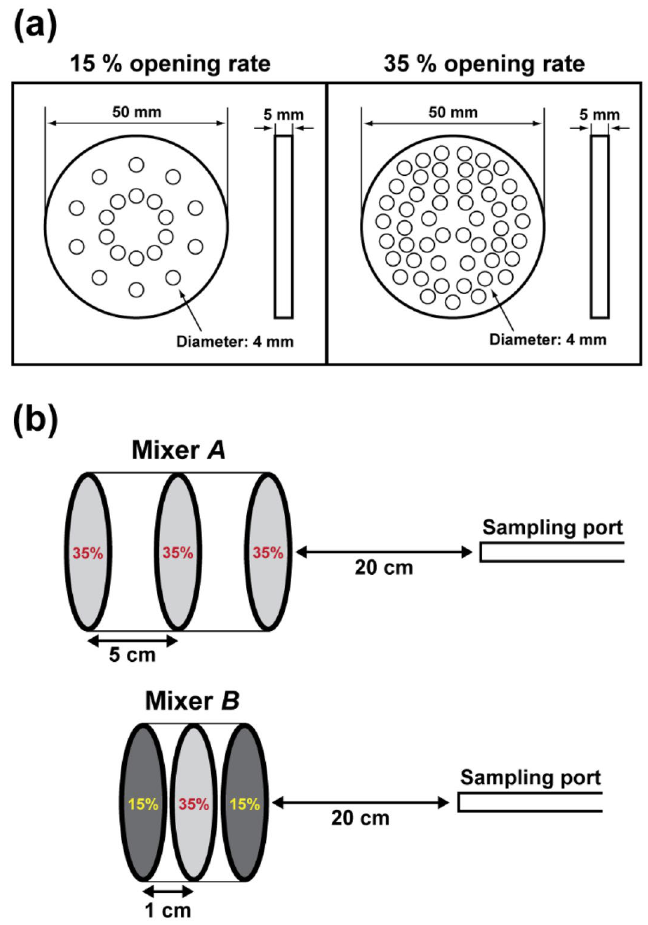
Figure 2. Information of Mixer A and B : ( a ) design of two perforated metals with 15% (20 holes) and 35% (51 holes) opening rates; ( b ) two combinations of the perforated